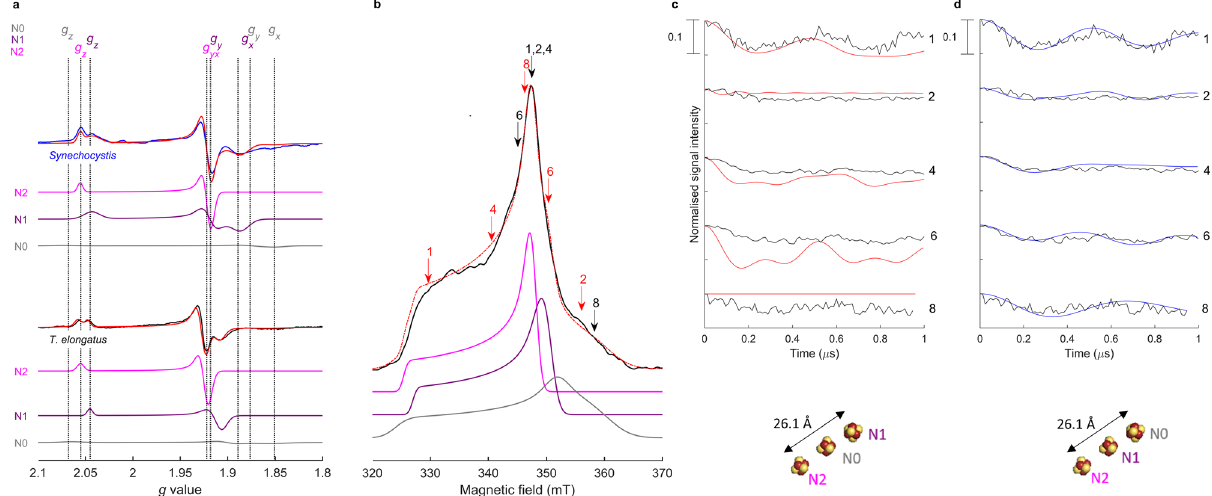
Fig. 2 Assignment of the FeS cluster EPR signals to the structure of T. elongatus PS-CI using DEER spectroscopy. a Continuous-wave EPR spectra (15 K) of the FeS clusters in sodium dithionite reduced PS-CI (Photosynthetic complex I) of Synechocystis (blue) and T. elongatus (black), 2 mW, 100 kHz modulation frequency, 7 G modulation amplitude. Simulations of the total (red) and individual N2 (pink), N1 (purple) and N0 (grey): Synechocystis g values: N2 ( g x,y = 1.922, g z = 2.055), N1 ( g x = 1.886, g y = 1.927, g z = 2.043), N0 ( g x = 1.851, g y = 1.867, g z = 2.079); T. elongatus g values: N2 ( g x,y = 1.922, g z = 2.055), N1 ( g x = 1.907, g y = 1.913, g z = 2.045), N0 ( g x = 1.852, g y = 1.899, g z = 2.064); See Supplementary Table 3 for full simulation parameters. b Set up of the pump pulse positions (red) and detection pulse position (black) for the corresponding DEER traces (for full experimental set up see Fig. S3) (10 K). Echo-detected fi eld sweep of T. elongatus (black), the sum of simulations (red), N2 (pink), N1 (purple), N0 (grey) (N2:N1:N0 ratio 1.00:0.92:0.90); see Table S3 for simulation parameters. c , d T. elongatus orientation-selective DEER traces for the corresponding pump and probe positions (black) (10 K). The modulation depth is indicated as a scale bar. c Best- fi t simulated DEER traces for model A, with the N1 cluster at 26.1 Å from N2 (red). d Best- fi t simulated DEER traces for model B, with N0 at 26.1 Å from N2 (blue). Schematics of the structural models are shown below. Note that the shorter distances (i.e. dipolar coupling to the middle cluster) do not contribute to the DEER traces; see Supplementary Note 2 for details on the simulation of the DEER traces and models employed. See Fig. S4 for a complete set of the DEER traces and